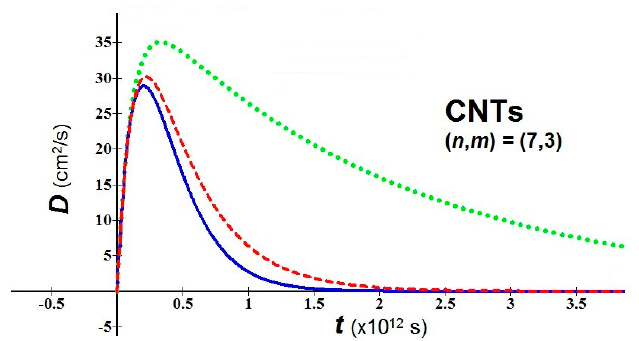
Figure 2. D vs. t for CNTs with ( n , m ) = (3,1). I α = 0.1 = blue solid line; I α = 0.5 = red dashed line; I α = 0.9 = green dot line.